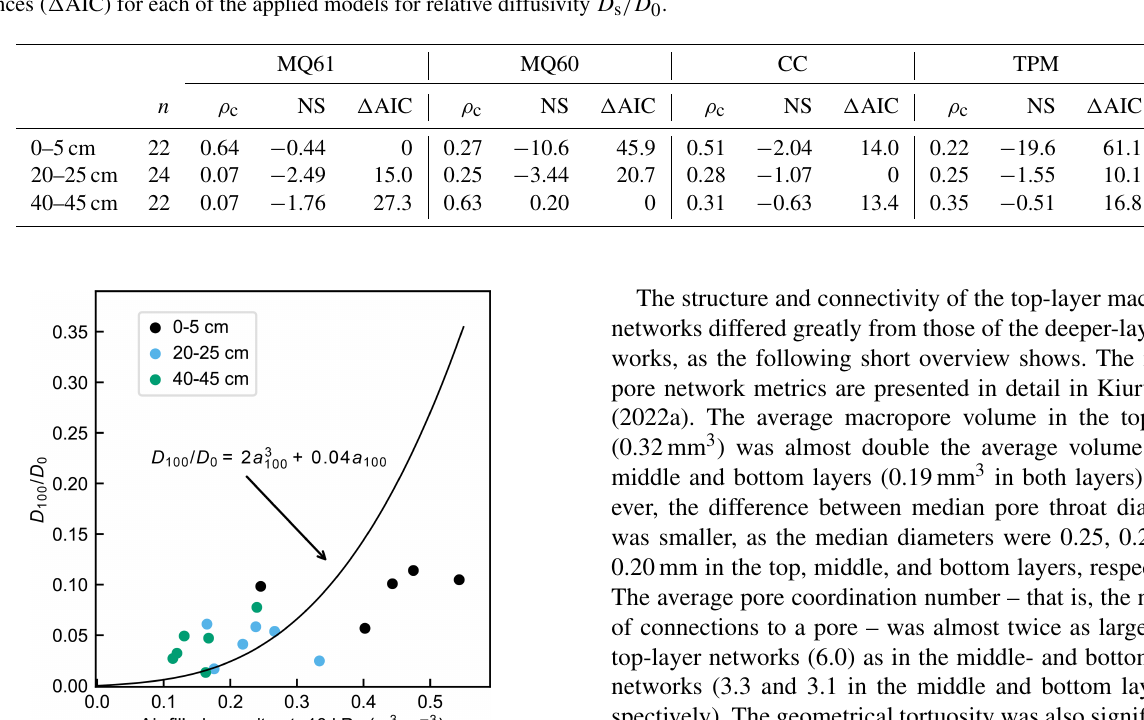
Table 3. Lin’s concordance correlation coefficients ( ρ c ), Nash–Sutcliffe efficiency coefficients (NS), and Akaike information criterion dif- ferences ( (cid:49) AIC) for each of the applied models for relative diffusivity D s /D 0 .